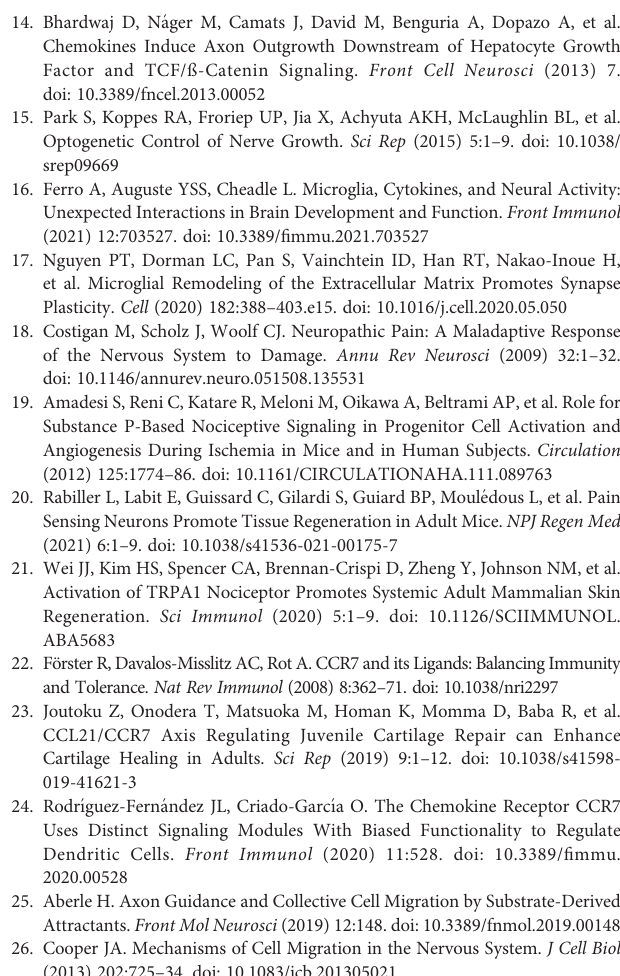
Supplementary Figure 1 | ChR2 expression in Thy1-ChR2 DRGs. (A) Graph showing the proportion of ChR2 + cells depending on the neuronal diameter. ChR2 is expressed in both large-diameter (>35 m m) and small-diameter (35-15 m m) neurons. (B) ChR2 expression in Thy1-ChR2 DRGs. Scale bar: 50 m m. Supplementary Figure 2 | Pertussis toxin addition does not prevent the CCL21- dependent neurite outgrowth increase. Data are expressed as mean fold change of average neurite length per neuron vs each vehicle ± s.e.m; n=9-12